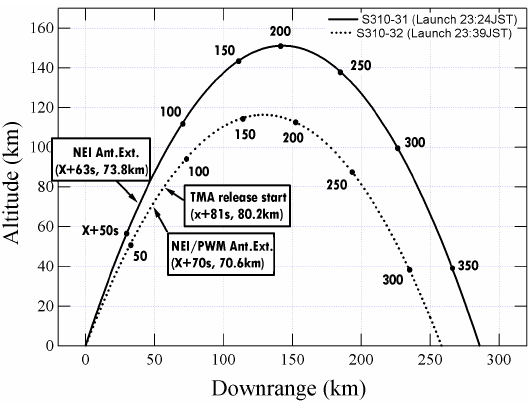
(Beryllium-Copper) dipole antenna, and detected wave is subtracted